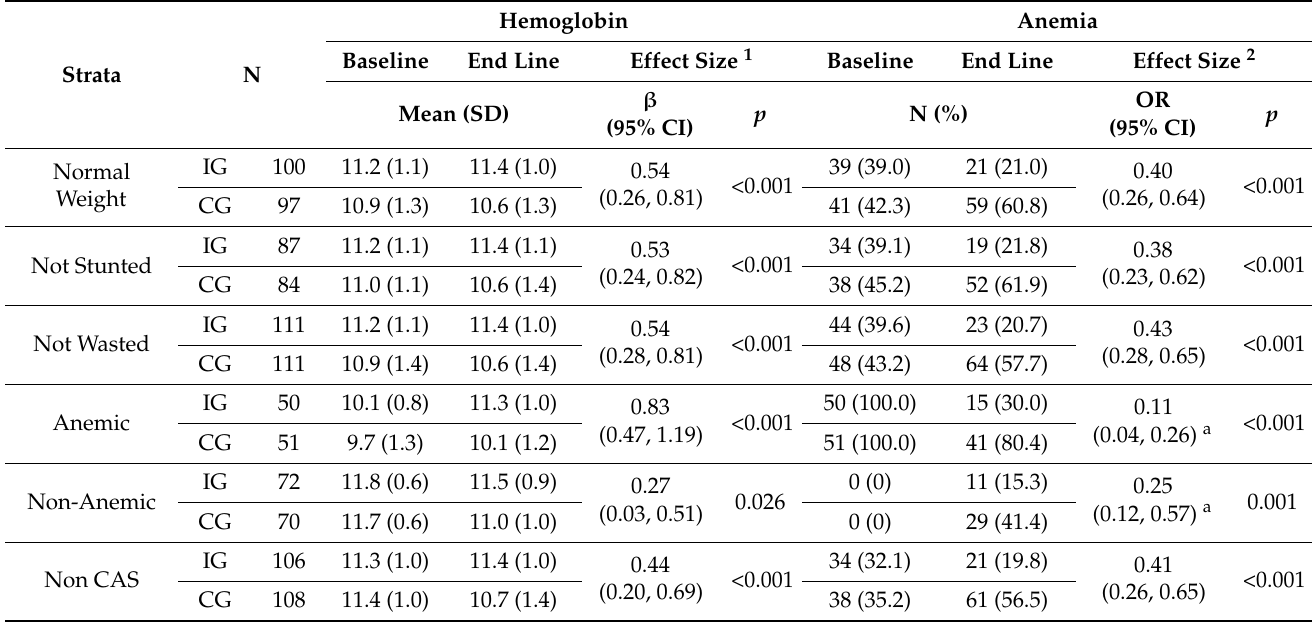
Table 3. Intervention effect on hemoglobin and anemia among groups stratified by baseline nutrition, anemia and CAS status.